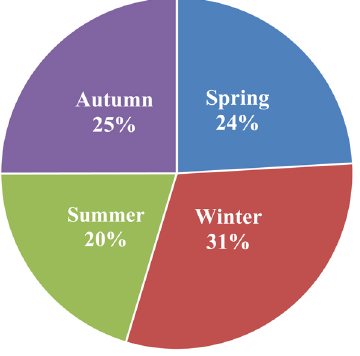
Figure 12. Seasonal distribution of technological